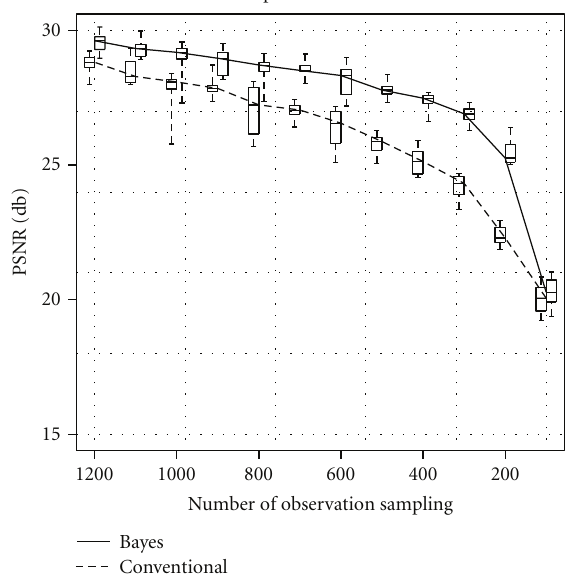
Figure 6: Qualities of reconstruction images measured by PSNR. The horizontal axis shows the SD of the sampling level, which means the inverse of the Poissonian noise. The vertical axis shows the PSNR. The solid line shows the median of the 10 trials of our Bayesian inference results, and box plot shows quartile deviation. The dashed line shows the results of the conventional FBP